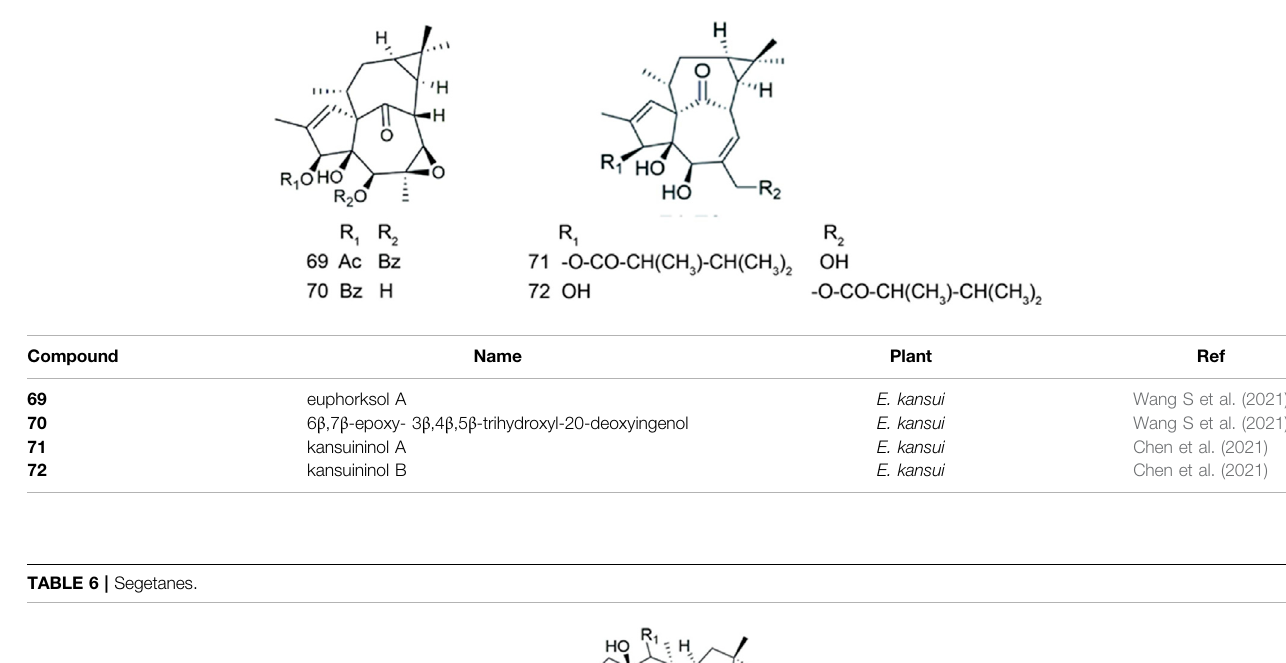
TABLE 5 | Ingenanes.